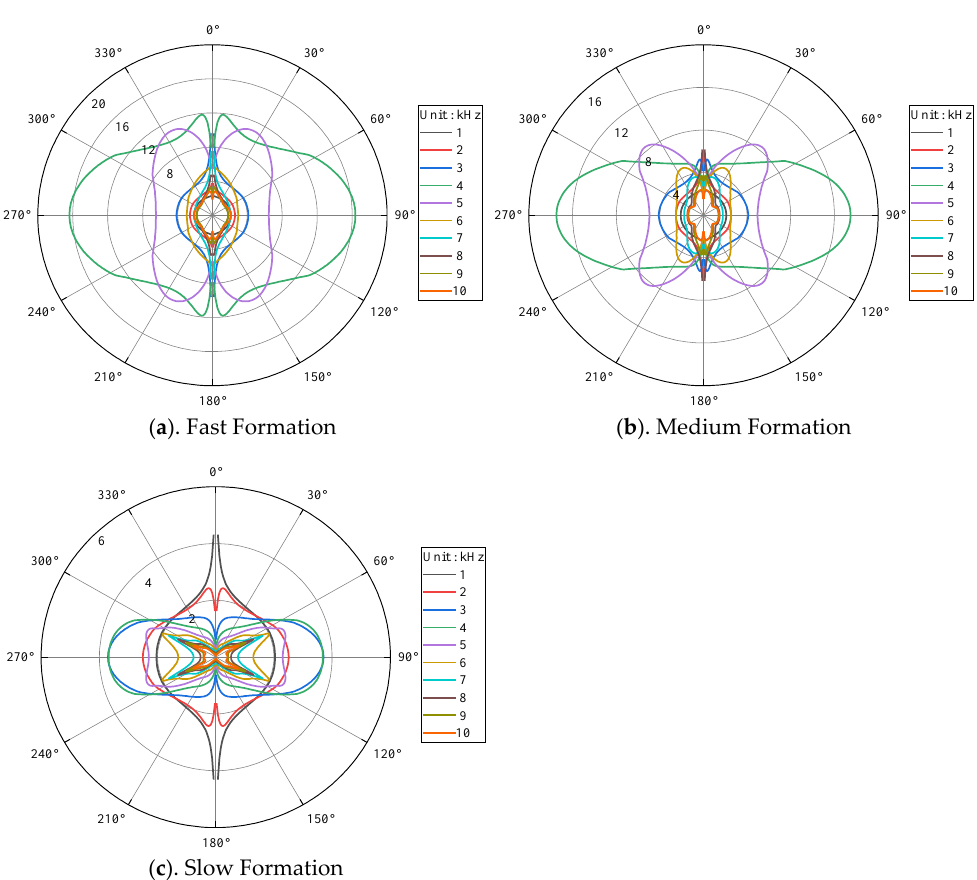
Figure 8. Radiation characteristics of SH–wave of a dipole source in different formations under different main frequencies.